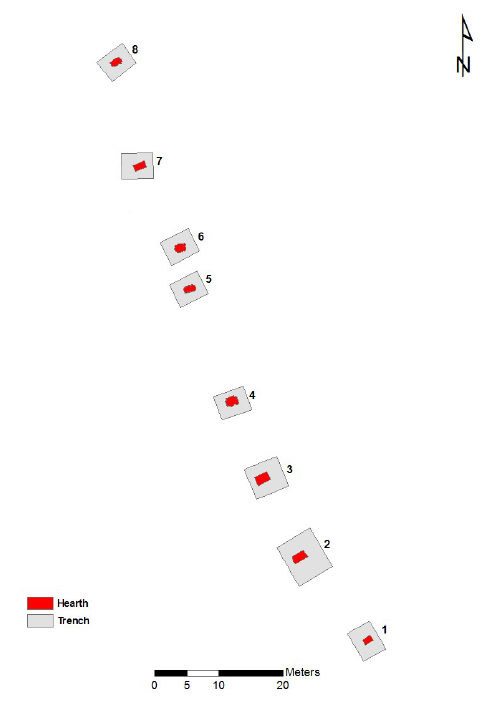
Figure 2b. Site plan of Steintjørna, illustration Philip Jer- and.